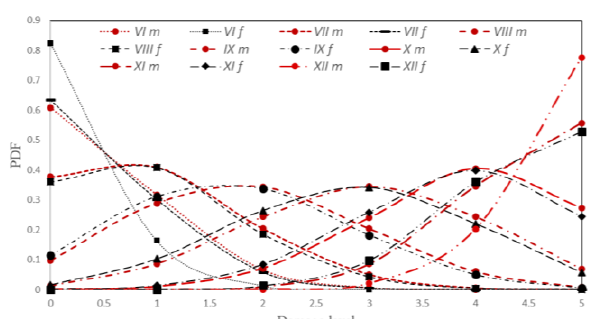
Figure 12. Comparison between the damage probability matrices for the aggregate studied both through the two different